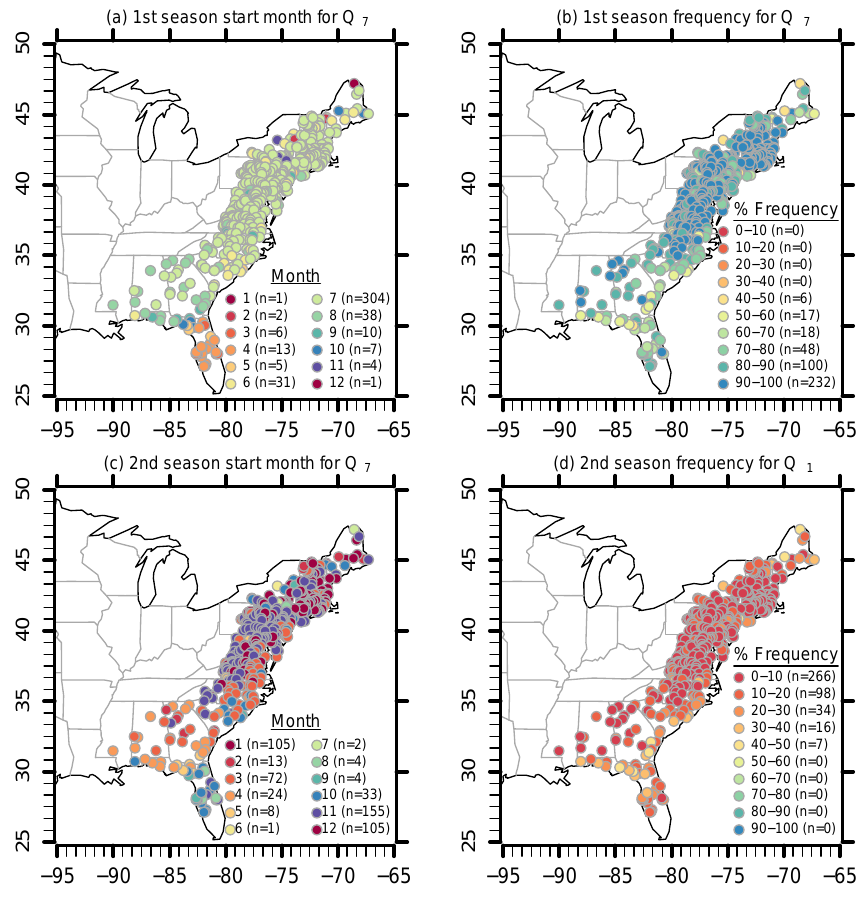
Figure 8. Primary and secondary seasons of occurrence of Q7 low flows and their frequencies.